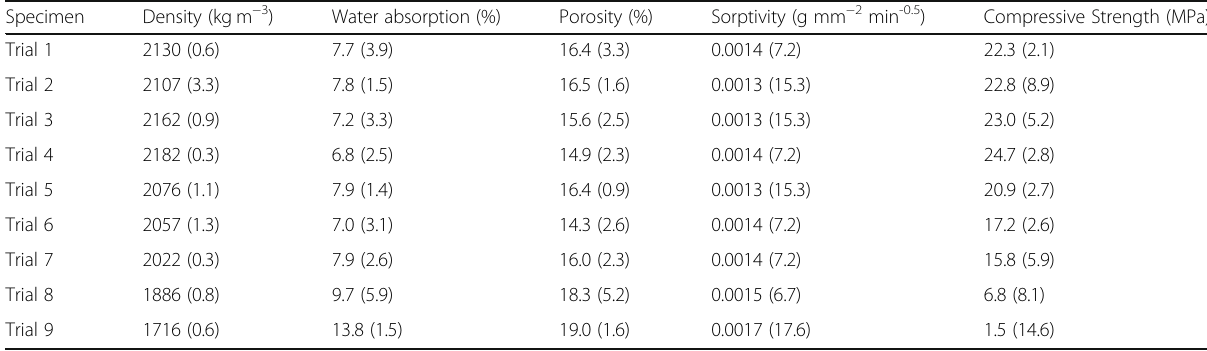
Table 3 Testing